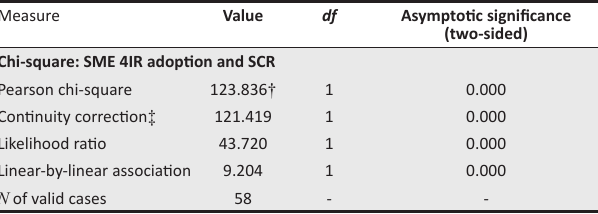
negative of 0 % (0/142), with an overall model correct TABLE 9: Chi-square on small and medium enterprise Fourth Industrial (two-sided)